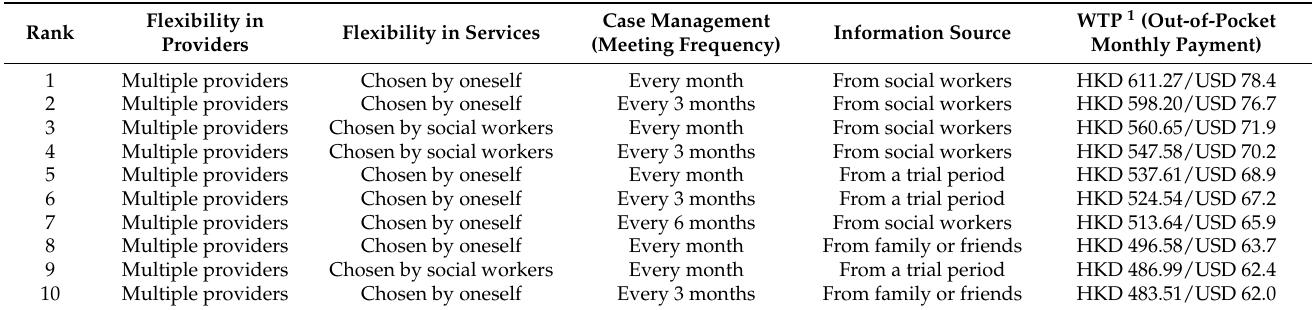
Table 4. Predicted 10 most preferred service models and their willingness to